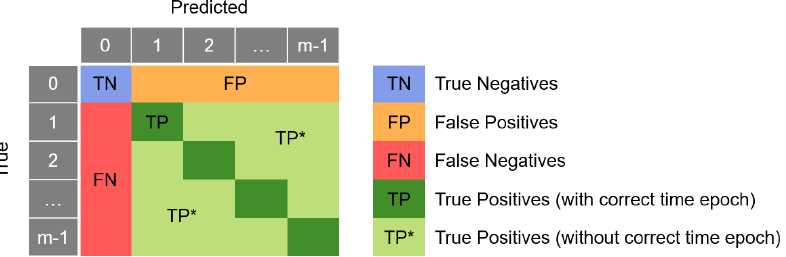
Figure 4. Confusion matrix for multi-class classification. Class 0 represents chunks with no dis- continuities. Class 1 until m − 1 represents chunks with discontinuities at the corresponding